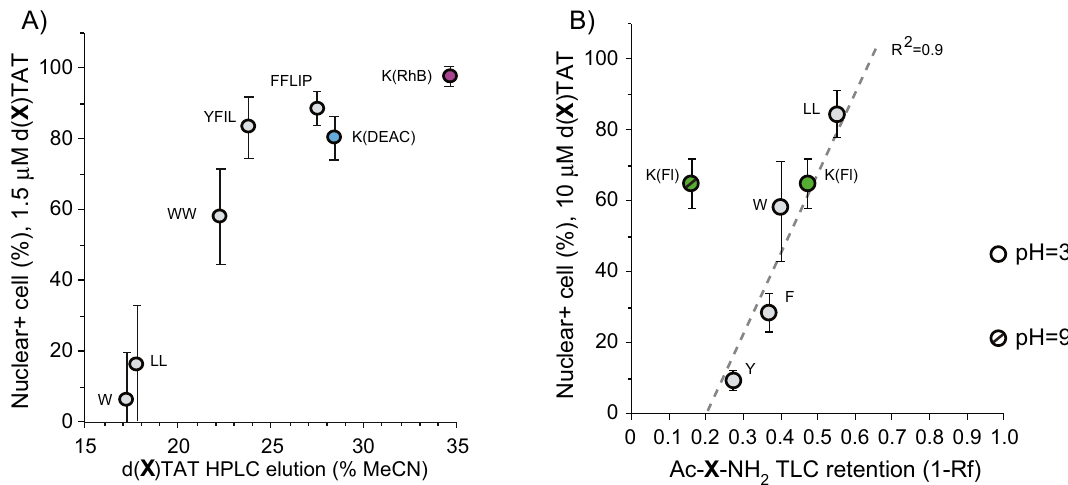
Figure 3. Correlation between CPP hydrophobicity and cell delivery. ( A ) Percentage of cells displaying TMR-k5 fluorescence in their nuclei as a function of the hydrophobicity of d(X)TAT. MDA-MB-231 cells were incubated with d(X)TAT (1.5 μM) and TMR-k5 (20 μM) for 1 h. The delivery data are the average and corresponding standard deviations obtained from biological triplicates. ( B ) Correlation between the delivery activity of d(X)TAT peptides and the hydrophobicity of the corresponding Ac-X-NH2 analogs. MDA-MB-231 cells were incubated with d(X)TAT (10 μM) and TMR-k5 (20 μM) for 1 h.